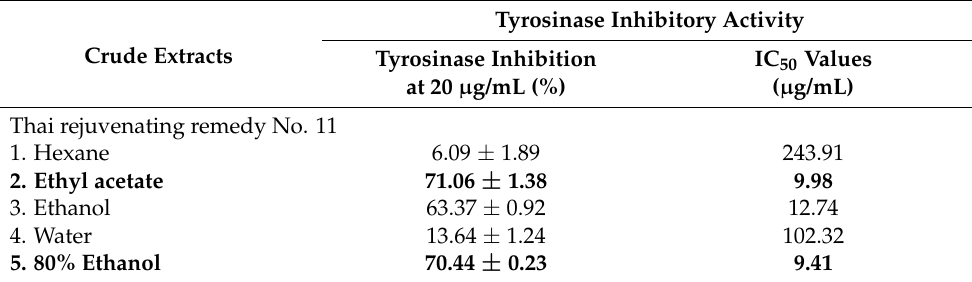
Table 1. Inhibitory effect of series solvents No. 11 remedy’s extracts against mushroom tyrosinase activity at 20 µ g/mL concentration.